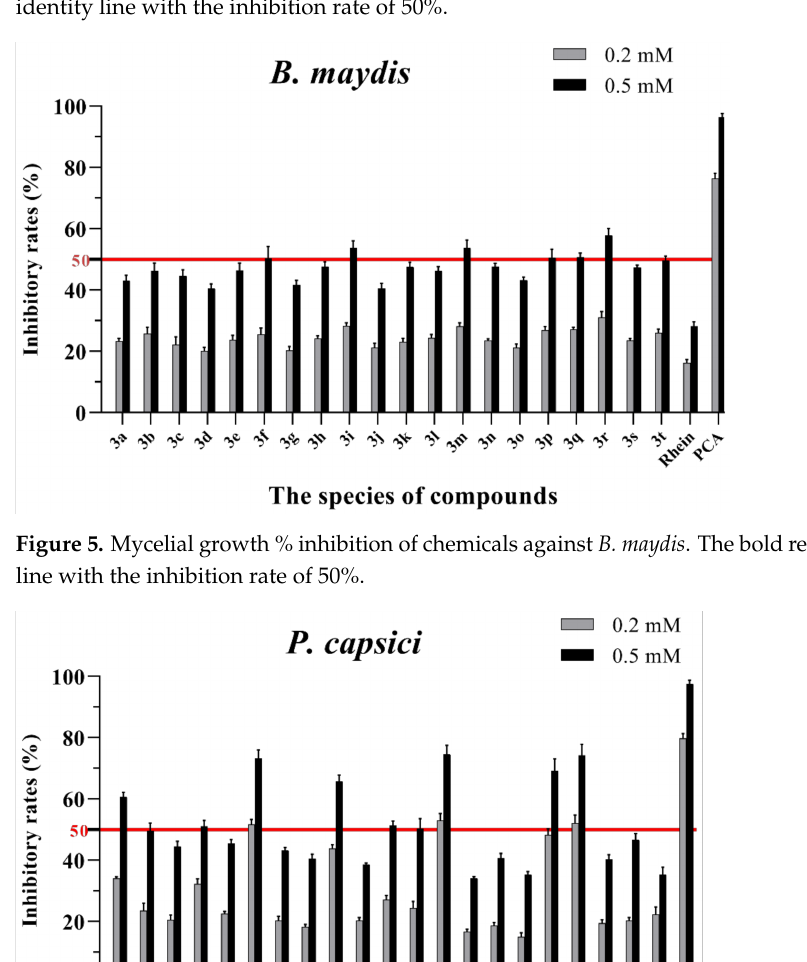
Figure 4. Mycelial growth % inhibition of chemicals against S. sclerotiorum . The bold red line is the identity line with the inhibition rate of 50%.